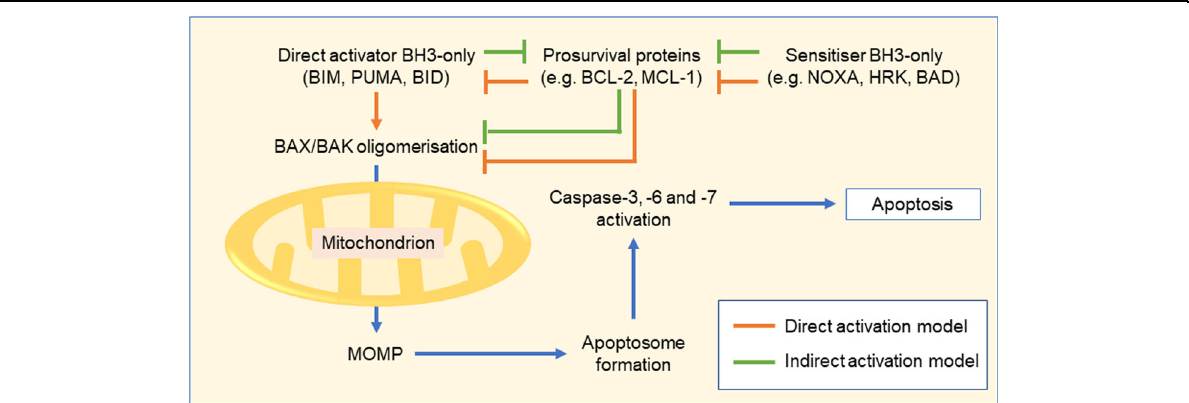
Fig. 2 Execution of the intrinsic apoptotic pathway requires activation of BAX and BAK to form pores in the outer mitochondrial membrane resulting in mitochondrial outer membrane permeabilisation (MOMP). BAX/BAK activation occurs through either the direct activation model, indirect activation model or a balance of both.